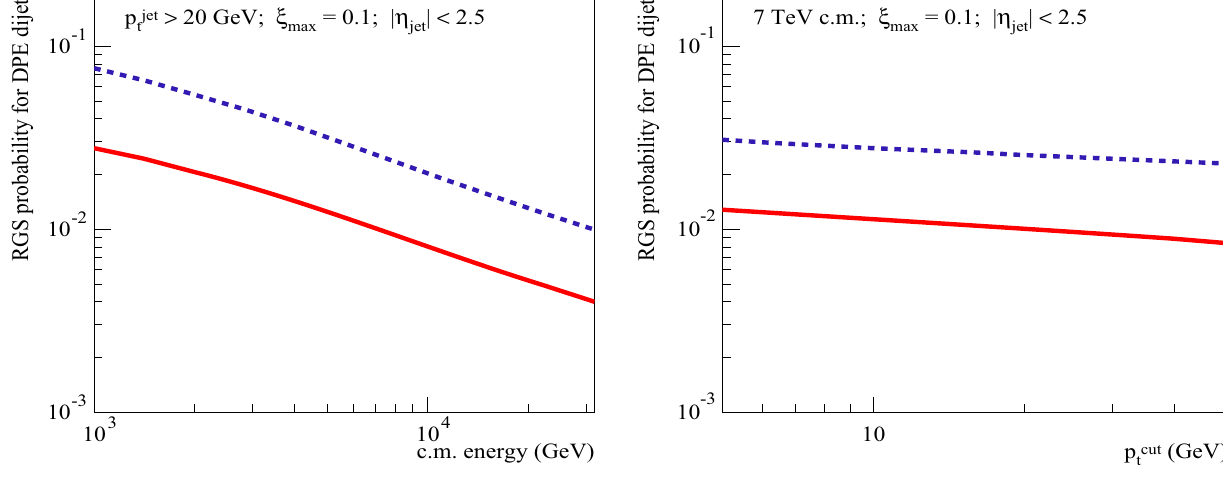
= 20 GeV/c (left) and p cut t